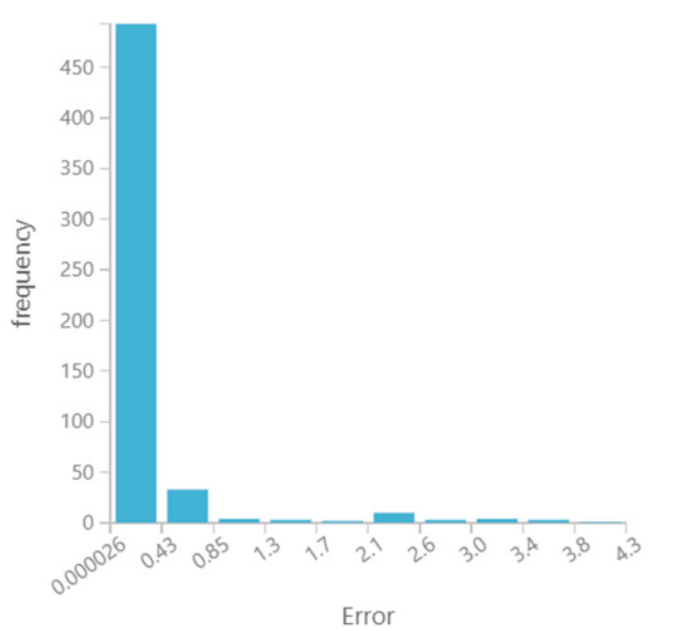
Figure 8. Scatter plot comparing the predicted values of the dc / dt using neural network method with the actual values of the dc / dt for an industrial dataset with the two operating parameters of total oxygen flow and lance height only.